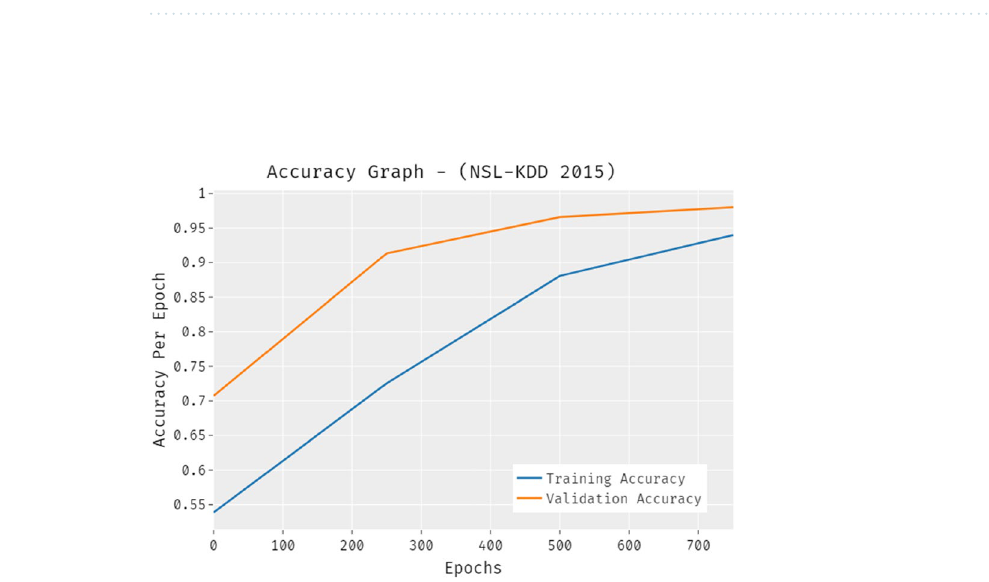
Figure 6. Comparative study of PRO-DLBIDCPS technique NSL-KDD-2015 dataset.